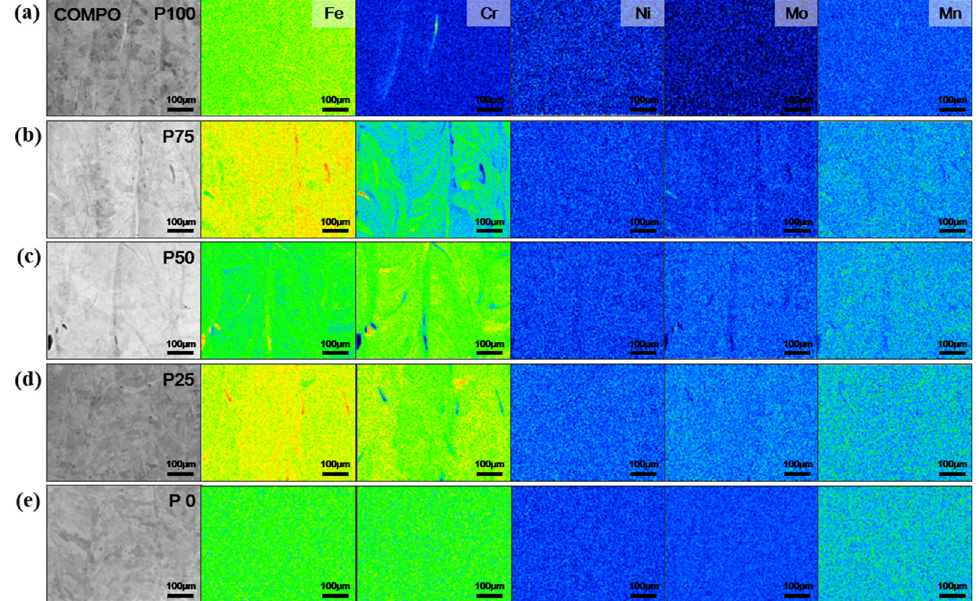
Figure 11. EPMA COMPO images and major components distributions by location and mixing ratio in FGM sample: ( a ) P21 100–STS316L 0%; ( b ) P21 75–STS316L 25%; ( c ) P21 50–STS316L 50%; ( d ) P21 25–STS316L 75%; ( e ) P21 0–STS316L 100%.